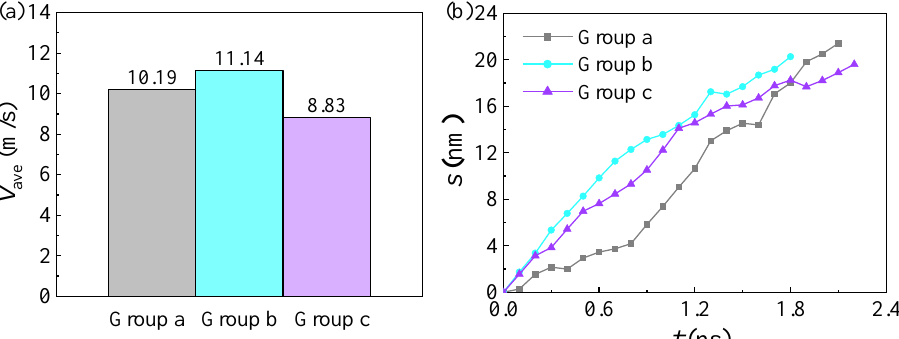
Figure 7. Instantaneous pictures showing the droplet motion on the surfaces of tracks with different widths. (a) The track witdh l b is 11.76 Å ; (b) The track witdh l b is 19.6 Å ; (c) The track witdh l b is 27.44 Å . Red center line is marked to assist in observing droplet movement.